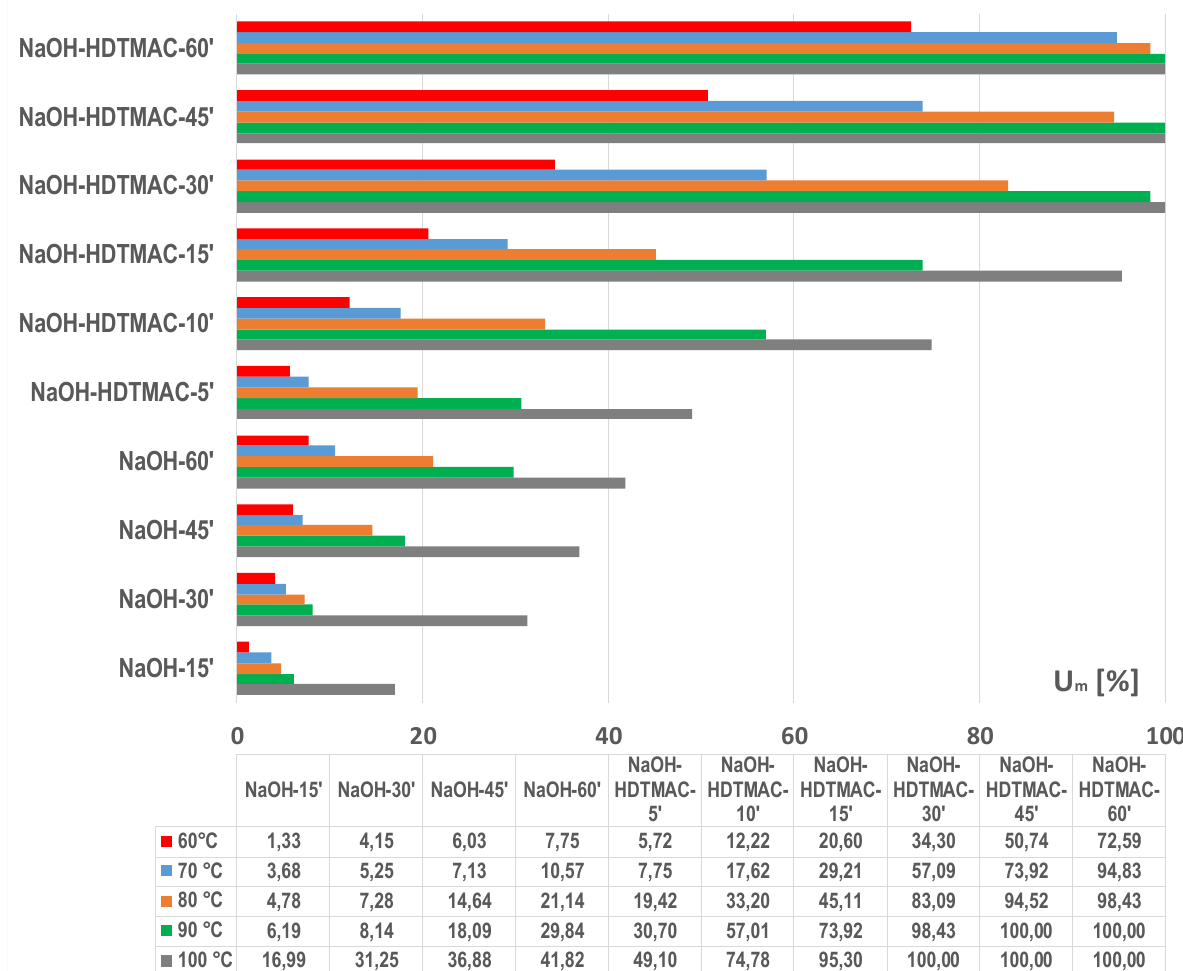
Figure 5. The PET fabric damage after alkali hydrolysis in 1.5 mol cm − 3 NaOH without and with addition of HDTMAC at temperature range 60 to 100 °C expressed as mechanical damage (U m ).